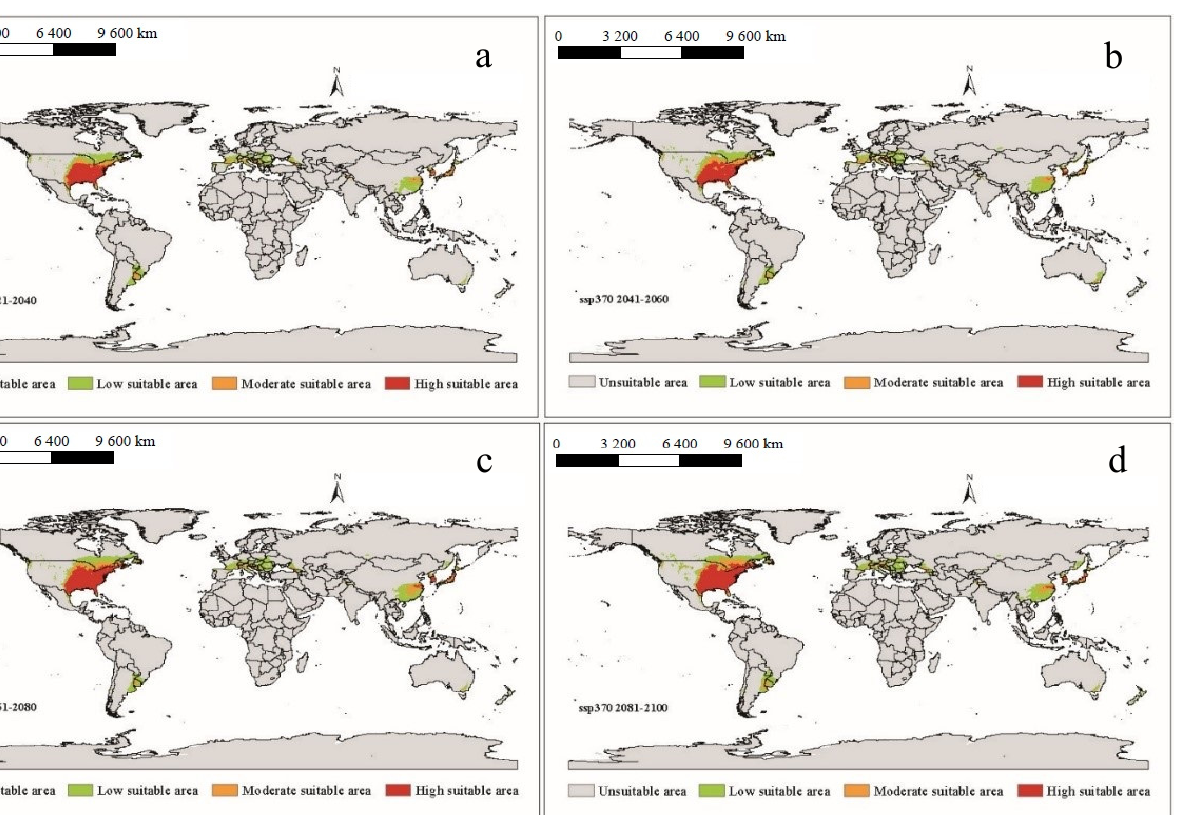
Table 2. Current and future suitable area for Amblyomma americanum across the world under different climatic conditions (×10 6 km 2 ).